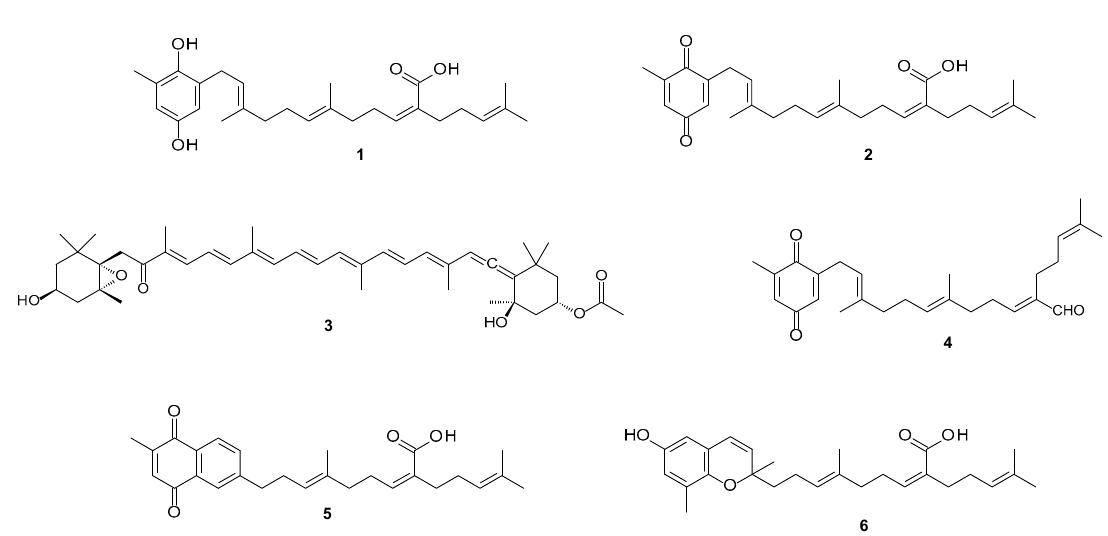
Figure 1. Sargassum incisifolium metabolites sargahydroquinoic acid ( 1 ), sargaquinoic acid ( 2 ), fucoxanthin ( 3 ) and sargaquinal ( 4 ), and semi-synthetic derivatives sarganaphthoquinoic acid ( 5 ) and sargachromenoic acid ( 6 ).